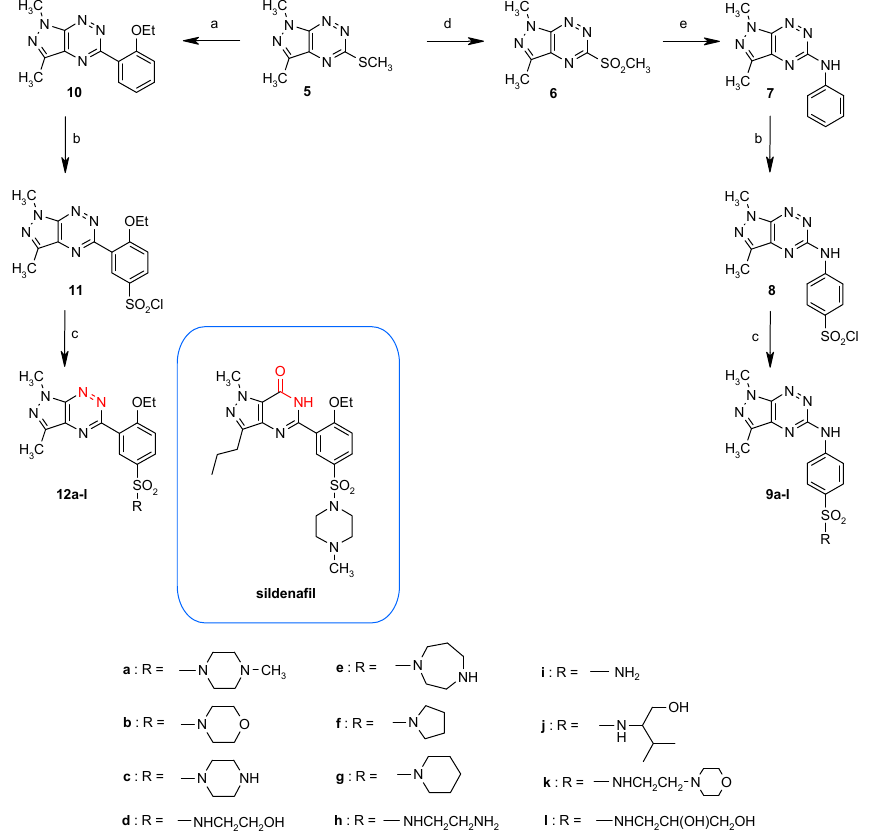
Scheme 6. Synthesis of sulfonamides. The reagents and reaction conditions: ( a ) 2-ethoxyphenylboronic acid, Pd(PPh 3 ) 4 , CuMeSal, THF, Ar, reflux, 12 h; ( b ) ClSO 3 H, 0–20 °C, 2 h; ( c )